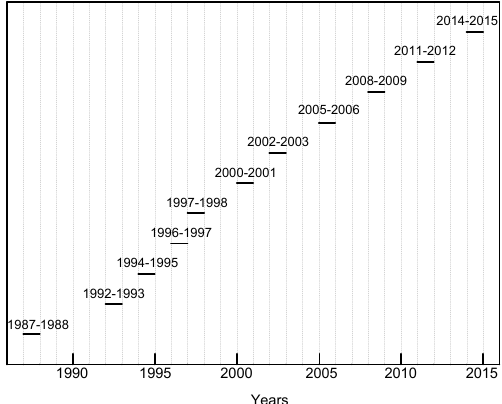
Figure 3. ICP/UNECE programme: Diagram showing the exposure sequences.